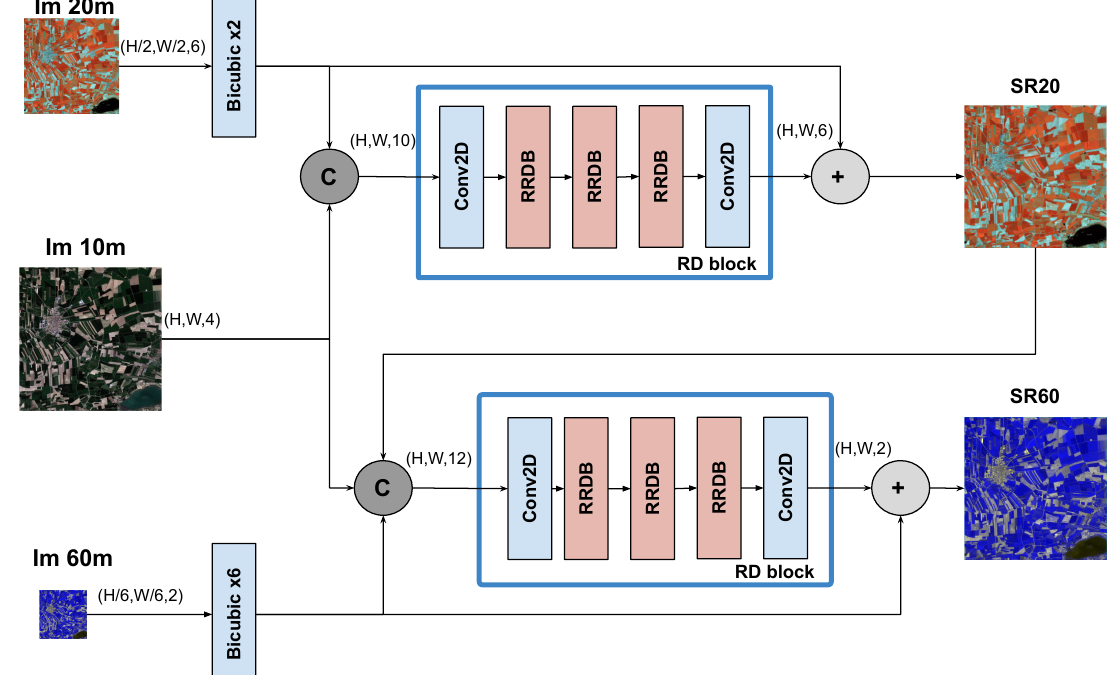
Figure 1. Sen2-RDSR model. The model produces two outputs, SR of 20 m bands and SR of 60 m bands. The RD blocks are composed of a convolutional layer, three RRDB blocks, and a convolutional layer that reconstructs the image with the corresponding output